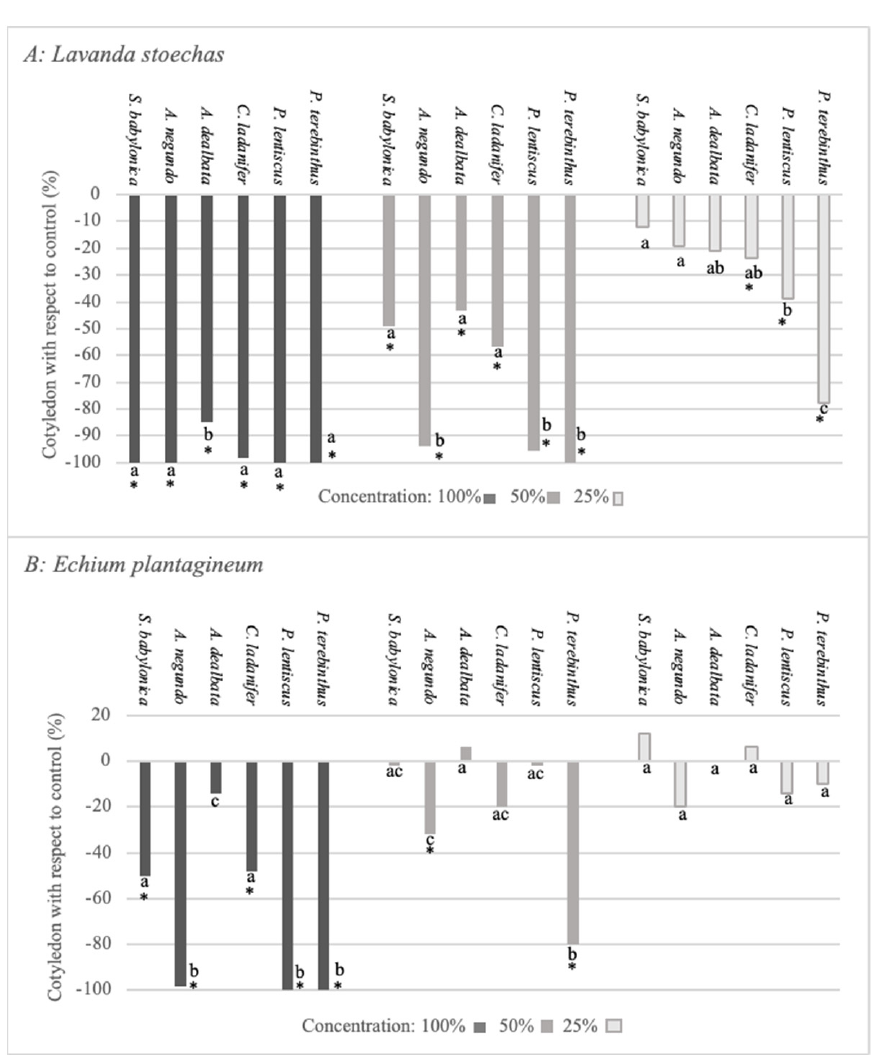
Figure 4. Effect of S. babylonica, A. negundo, A. dealbata, C. ladanifer, P. lentiscus, and P. terebinthus extract on cotyledon of L. stoechas ( A ) and E. plantagineum ( B ) at 100%, 50%, and 25% concentrations; a, b, c: lowercase letters indicate significant differences between species on the same concentration (Mann-Whitney test, p < 0.05). *: Significant difference of control (Mann-Whitney test, p < 0.05). Comparing the effect of the native species, as a group, with that of the non-native species (Table 2), the group of native species produced the greatest percentages of inhibition in the four parameters analysed in both target species. However, no significant differences were observed in germination, but differences were observed in root size, cotyledon emer- gence, and cotyledon size. For L. stoechas , there were significant differences between these 2 groups of species in root size and cotyledon emergence with extracts at 50% and 25%, and with 25% in cotyledon size. In E. plantagineum , the native species exerted a more signifi- cant inhibition on root size at all 3 concentrations, on cotyledon emergence at maximum concentration, and on cotyledon size at 100% and